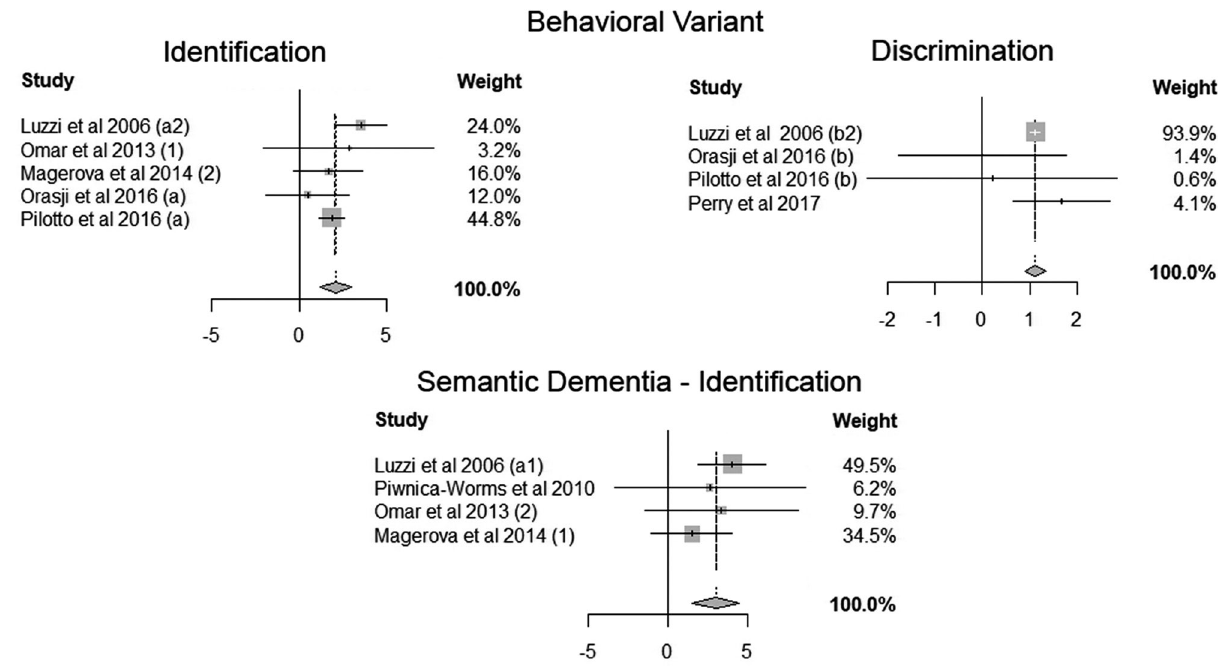
Figure 2. Summary of